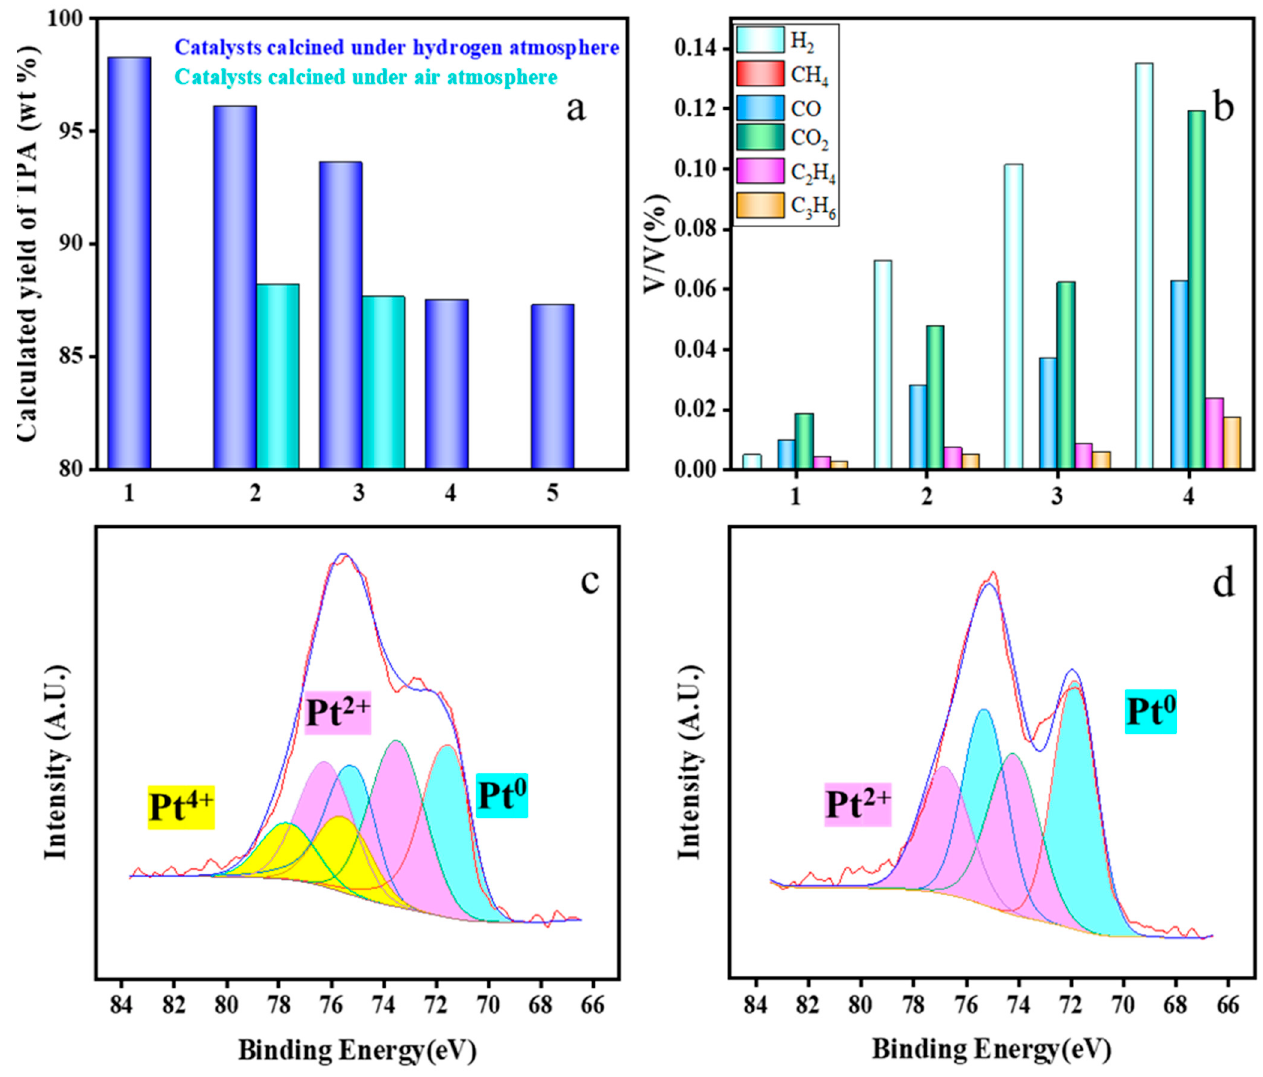
Figure 11. Product distribution in the catalyst recycling experiments: ( a ) variation of the calculated yield of TPA; ( b ) variations of the gas components; ( c ) XPS analysis of the catalysts after air calcination; ( d ) XPS analysis of the catalysts after hydrogen calcination. (The yellow area is Pt 4+ , the purple area is Pt 2+ and the blue area is Pt 0 )